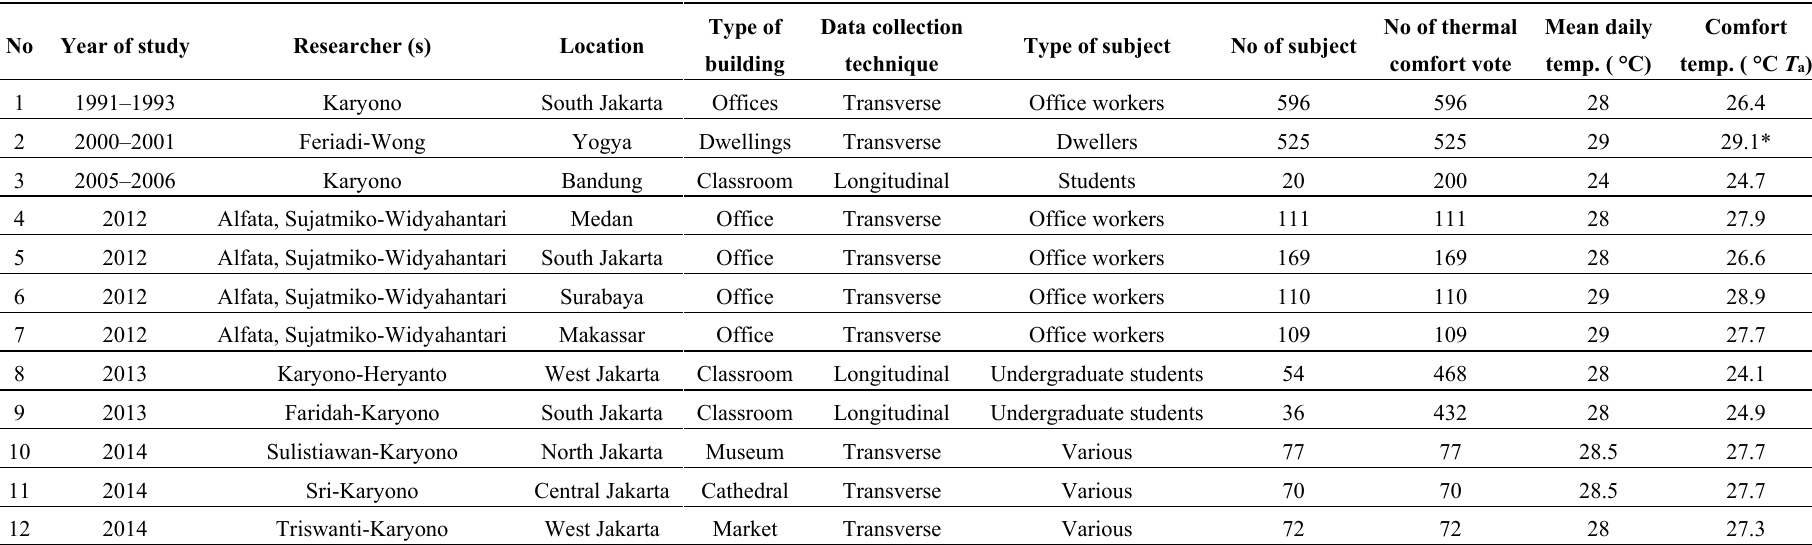
Table 1. Data from previous thermal comfort studies done in